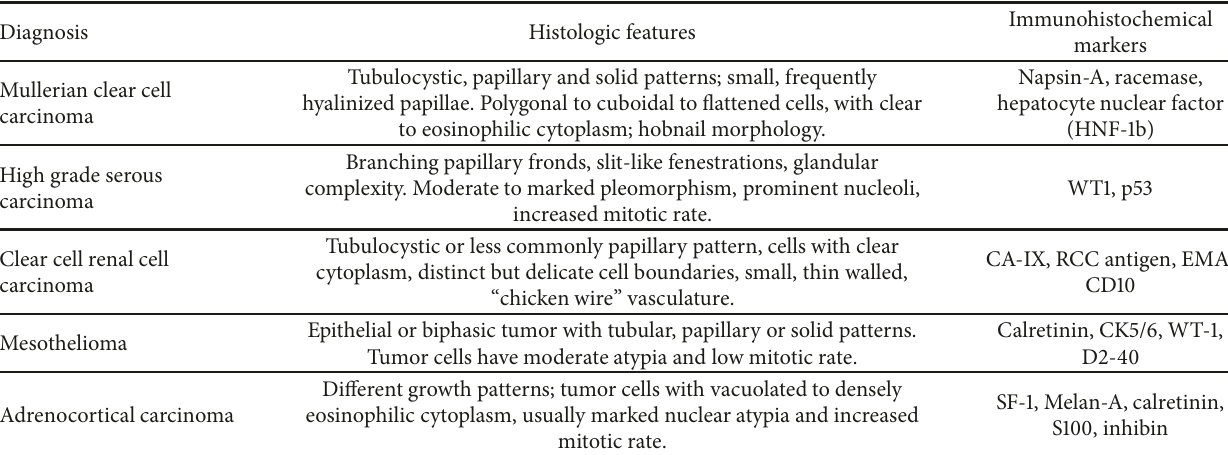
Table 1: Differential diagnosis of Mullerian clear cell